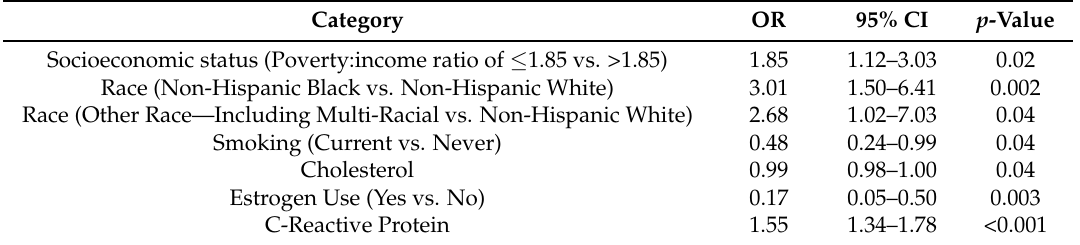
Table 4. The risk of serum retinol of less than 1.05 µ mol/L for variables significant in multivariate analysis. Category Socioeconomic status (Poverty:income ratio of ≤ 1.85 vs. >1.85) Race (Non-Hispanic Black vs. Non-Hispanic White) Race (Other Race—Including Multi-Racial vs. Non-Hispanic